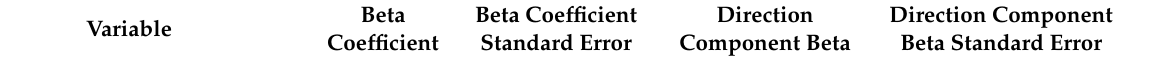
Table 5. Impact of demographic, clinical, angiographic, biochemical and electrocardiographic variables on left ventricular ejection fraction (LVEF) 6 months after STEMI. The model was obtained using multiple regression by adding all electro- cardiographic variables to the demographic, clinical and angiographic data.